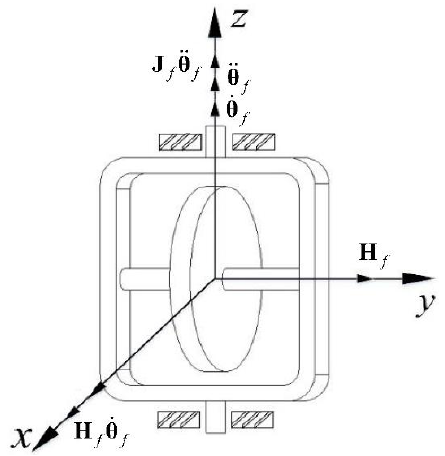
Figure 7. Schematic diagram of SGCMG system.